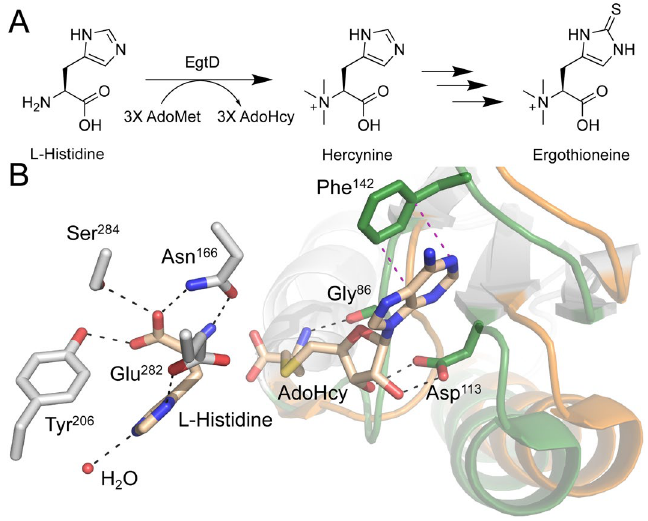
Figure 1. Synthesis of EGT and EgtD structure in actinobacteria. ( A ) Multi-step pathway in which L-Histidine is converted into EGT in M. tb . ( B ) Superposition of M. smegmatis EgtD in a complex with L-Histidine only (orange) and with both L-Histidine and AdoHcy (green) (PDB: 4uy6 and 4uy7). Residues interacting with L-Histidine are shown with gray carbons and those interacting with AdoMet are in